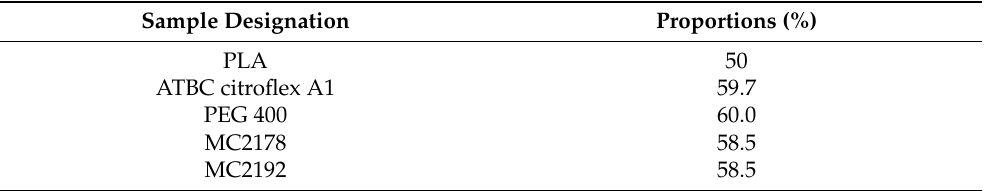
Table 2. The individual proportions of total organic carbon of